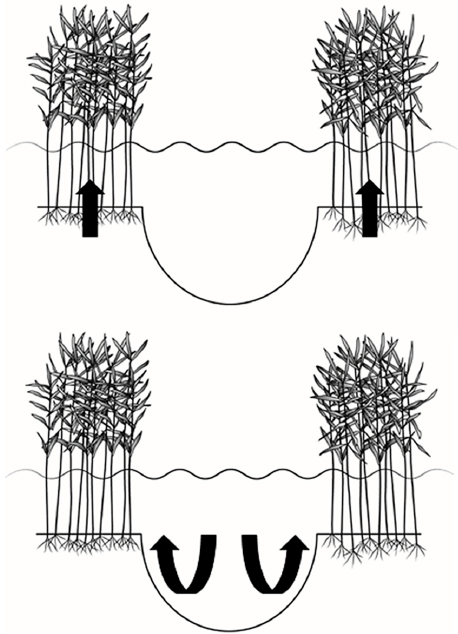
Figure 18. The hollow ways in Southern Mesopotamia may have formed by one of two processes: (1, above) tra ffi c through the water passages prevented the accumulation of soil, while soil continued to build up outside of the water passages; or (2, below) turbulence and traction from boat and water buffalo traffic through the water passages eroded the soil underneath.